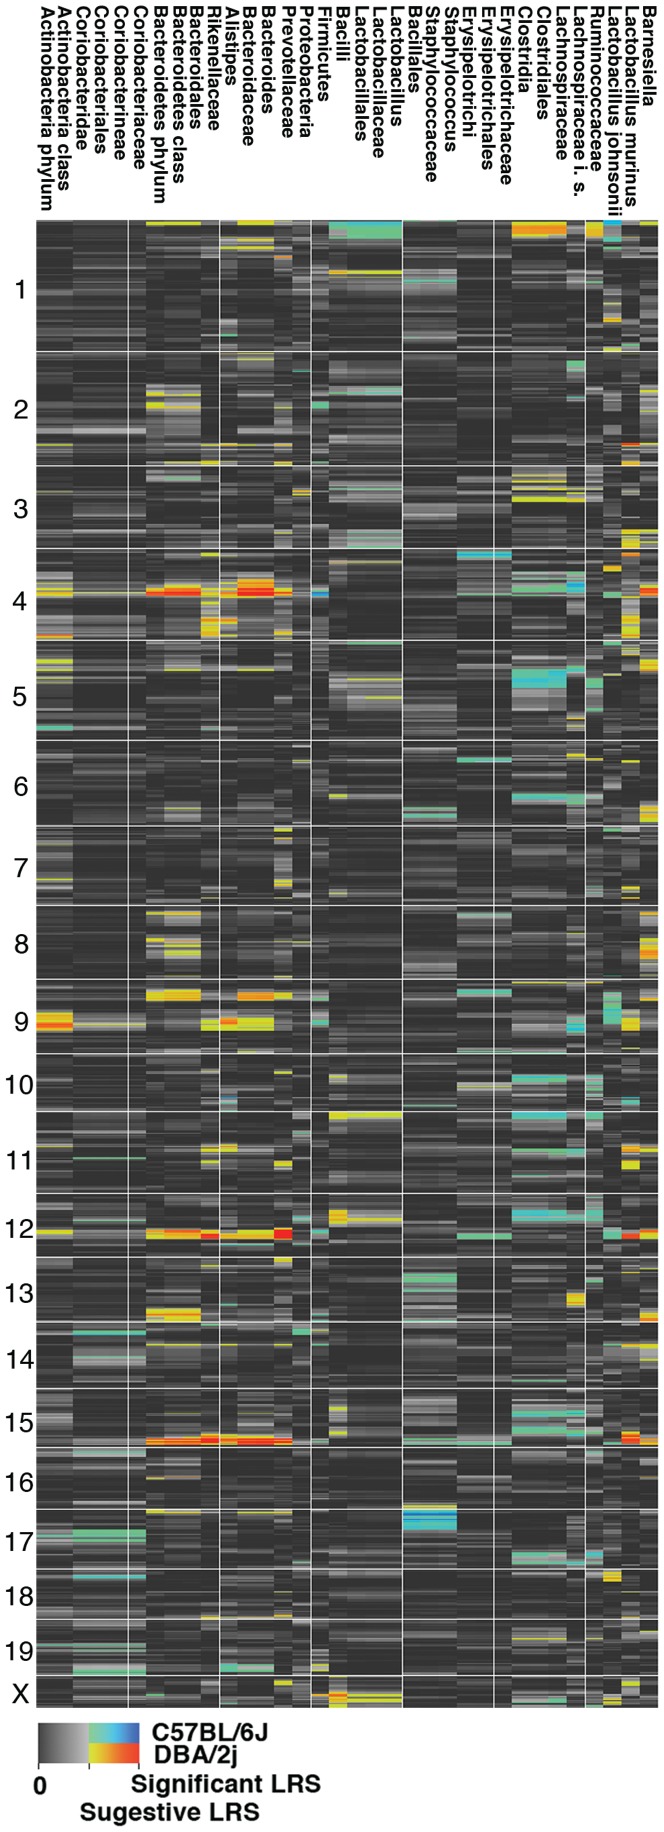
Genome-wide QTL mapping of the gut microbiota in BXD strains.The heat map is represented in “Grey+Blue+Red” in which more intense colors mark chromosomal regions with statistical values associated with high linkage while the spectrum indicates the allelic effect. The blue-green regions are those in which B allele is associated with higher trait values, whereas red-yellow regions are those in which the D allele is associated with higher trait values. Grey and black regions correspond to insignificant linkage between traits and DNA markers.